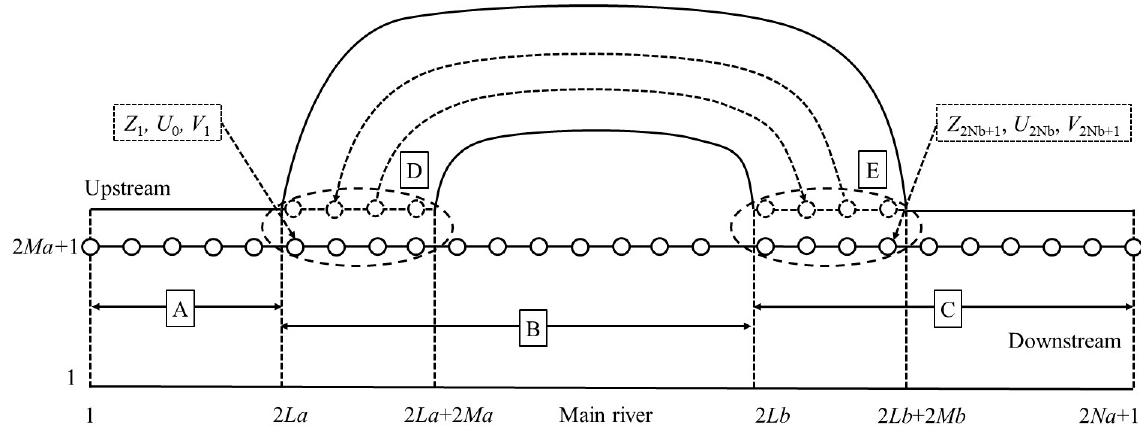
Figure 5. Details of loop river discretization